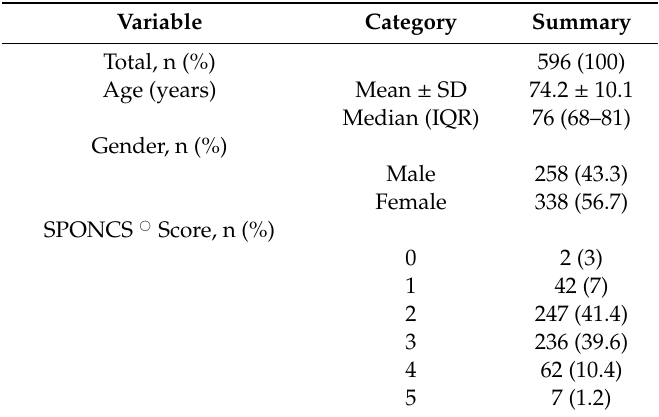
Table 4. Cohort baseline characteristics. Table 3. Cohort baseline characteristics.